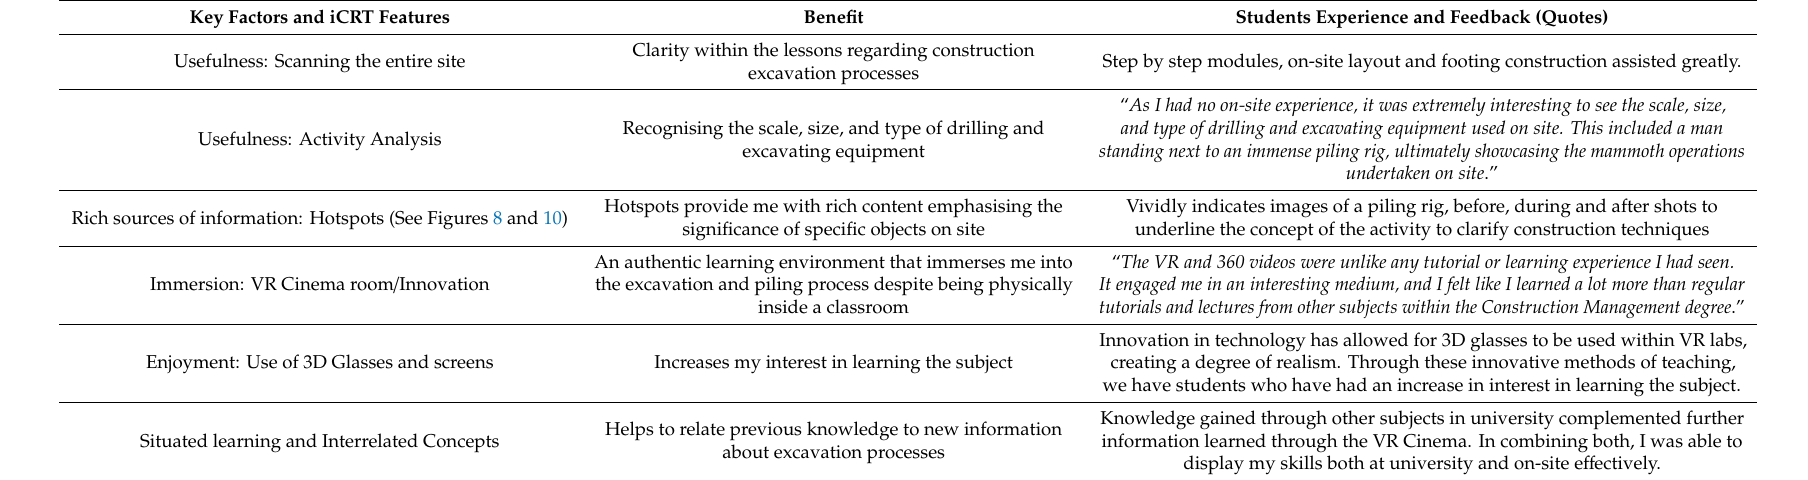
Table 6. Features identified from the analysis of student experience from selected